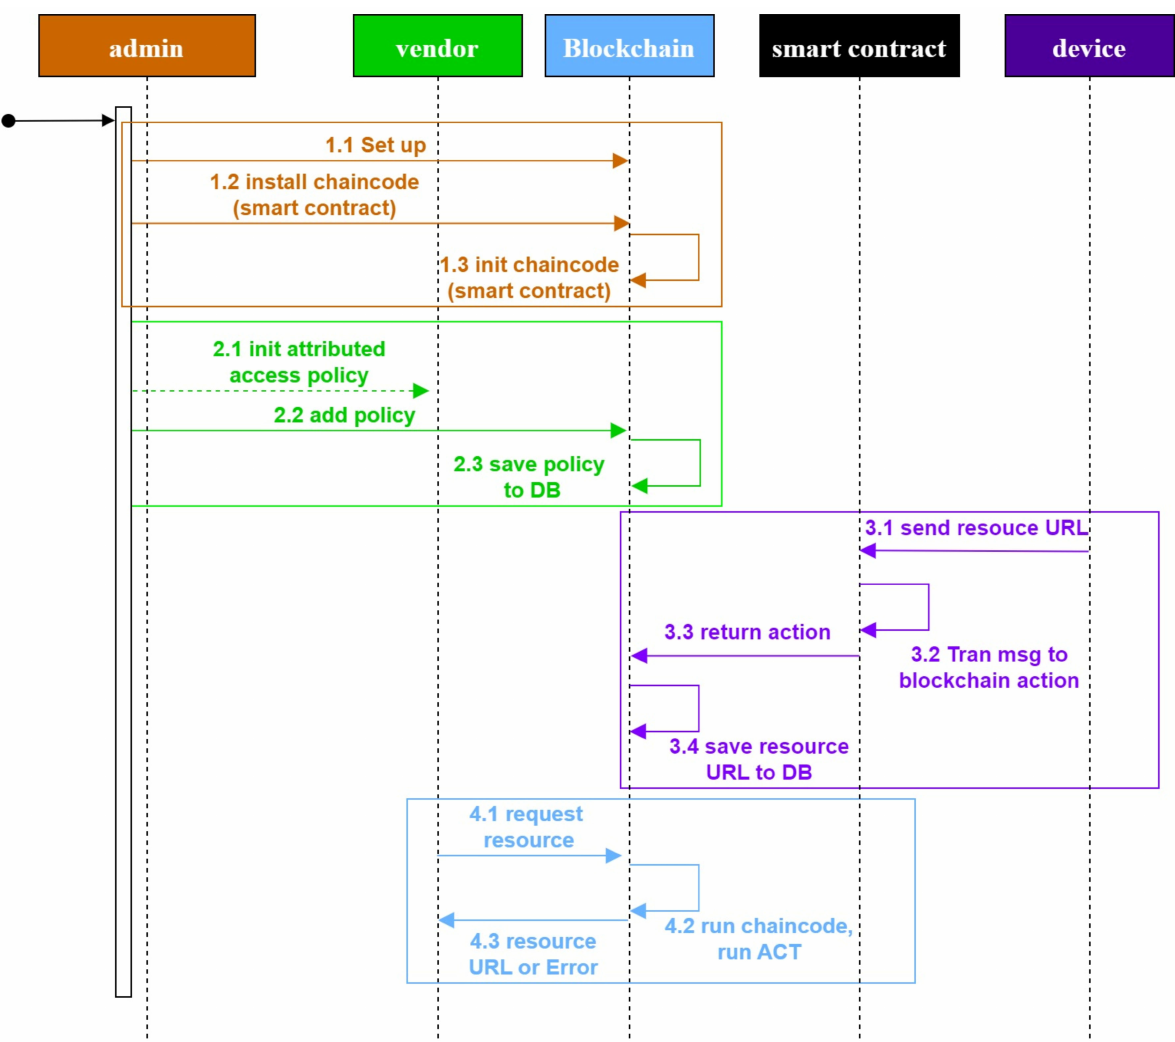
Figure 6. System sequence